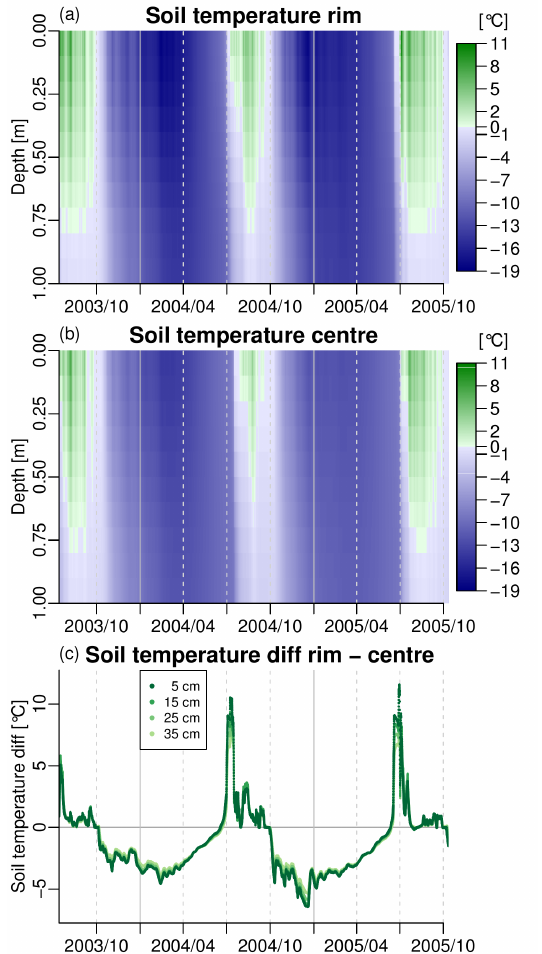
Figure B3. Modelled soil temperature of the uppermost metre at the (a) rim and (b) centre as well as (c) the difference rim minus centre at several depths. Solid lines indicate 1 January; dashed lines indicate 1 April, 1 July and 1 October of the respective year.